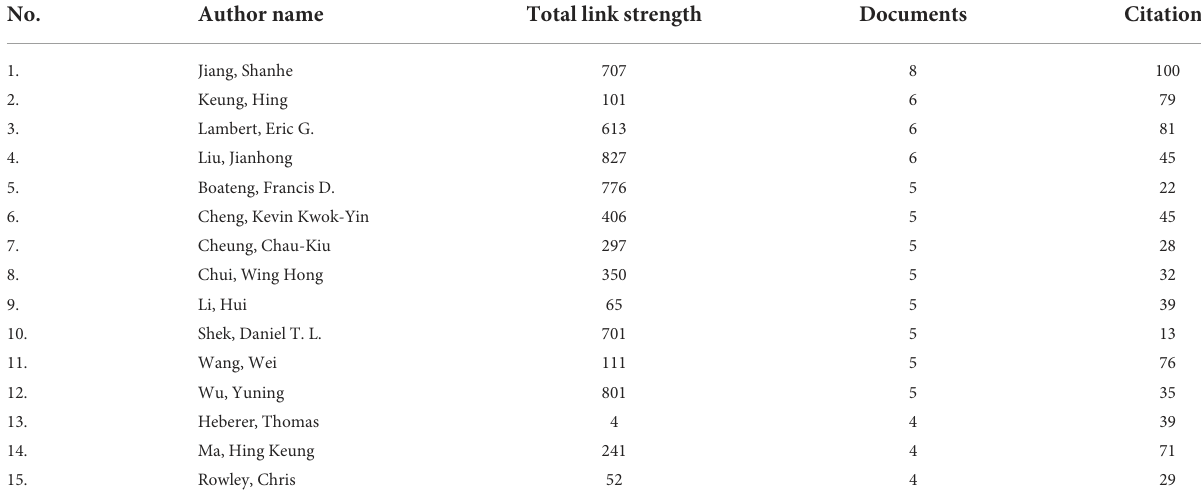
TABLE 2 No. of publications and citations based on